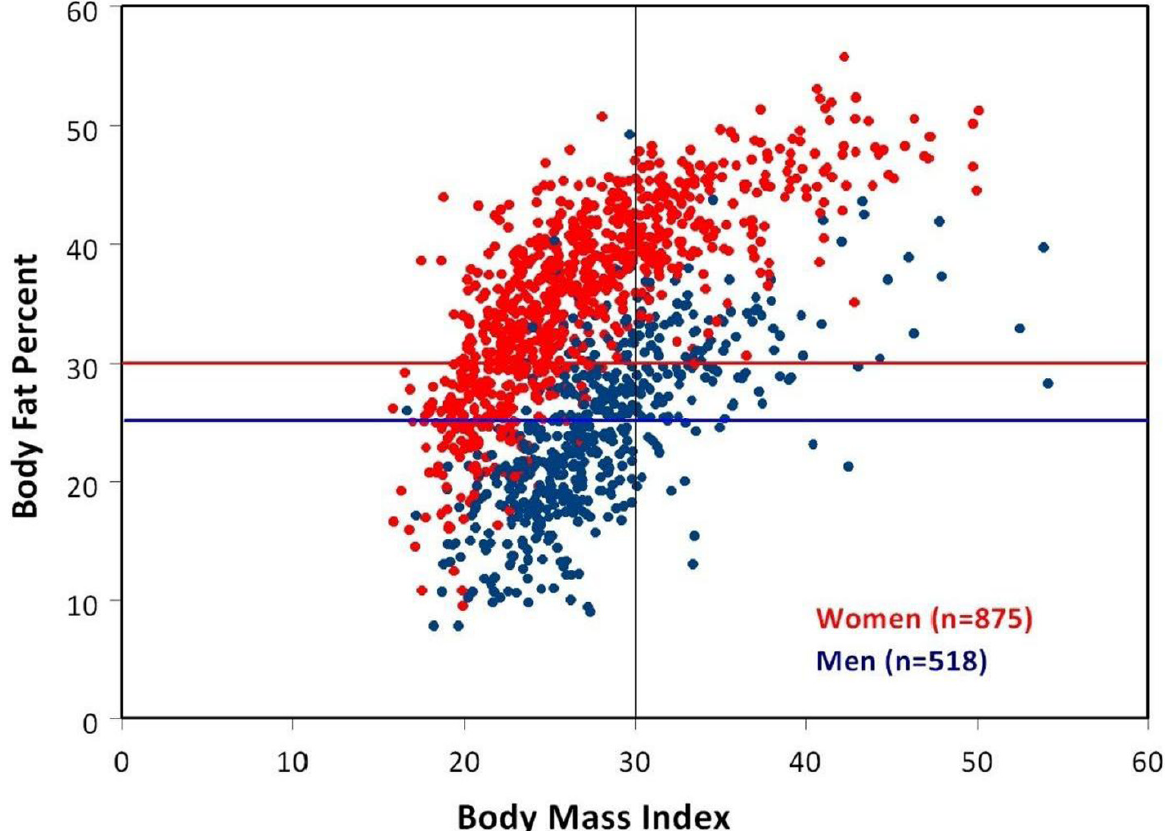
Figure 3. BMI versus percent body fat in the scatter plot. Women (red) who fall above the red line are obese according to the American Society of Bariatric Physicians criteria (DXA percent body fat: ≥ 30%). Men (blue) who fall above the blue horizontal line are obese according to the American Society of Bariatric Physicians criteria (DXA percent body fat: ≥ 25%). The upper left quadrant bordered by a red hori- zontal line (body fat percent = 30%) and black vertical line (BMI = 30) demonstrates the large number of women misclassified as “non-obese” by BMI yet “obese” by percent body fat [with permission from Shar and Braverman]. Anomalies in the Drd2 structure result in decreased dopamine receptor sites in the brain’s reward center. This leads to reduced effectiveness of dopamine communication between critical rewards sites [23–25]. Along these lines, Gluskin et al. [24] identified 21 studies examining 19 variants in 11 genes. Specifically, fixed- and random-effects meta- analyses of this variant (5 studies, 194 subjects total) revealed that striatal BP was signifi- cantly and robustly lower among carriers of the minor allele (rs1800497, Glu713Lys, also called ‘ Taq1A ’) relative to significant allele homozygotes ( P = 0.0002) supporting Blum and Noble’s first report [23]. Individuals possessing the Dopamine Receptor Gene variant tend to be serious co- caine abusers [26] and are predisposed to unhealthy appetites that can lead to obesity or overeating [27]. Conversely, these individuals are predisposed to develop anorexia and have high levels of stress over an extended period. Their addiction-prone neuro-circuitry manifests in maladaptive generalized craving behaviors leading to overconsumption of substances such as cocaine, alcohol, nicotine, and glucose (substances known to activate the NAc [addiction center of the brain]) in efforts to activate dopaminergic signaling in reward pathways. Such behaviors serve as a form of self-medication to offset their low D2 receptors caused by genetic antecedents (such as the D2 receptor gene Taq1 A1 allele [28]) . While the scientific community is very concerned about childhood obesity [29], it is also